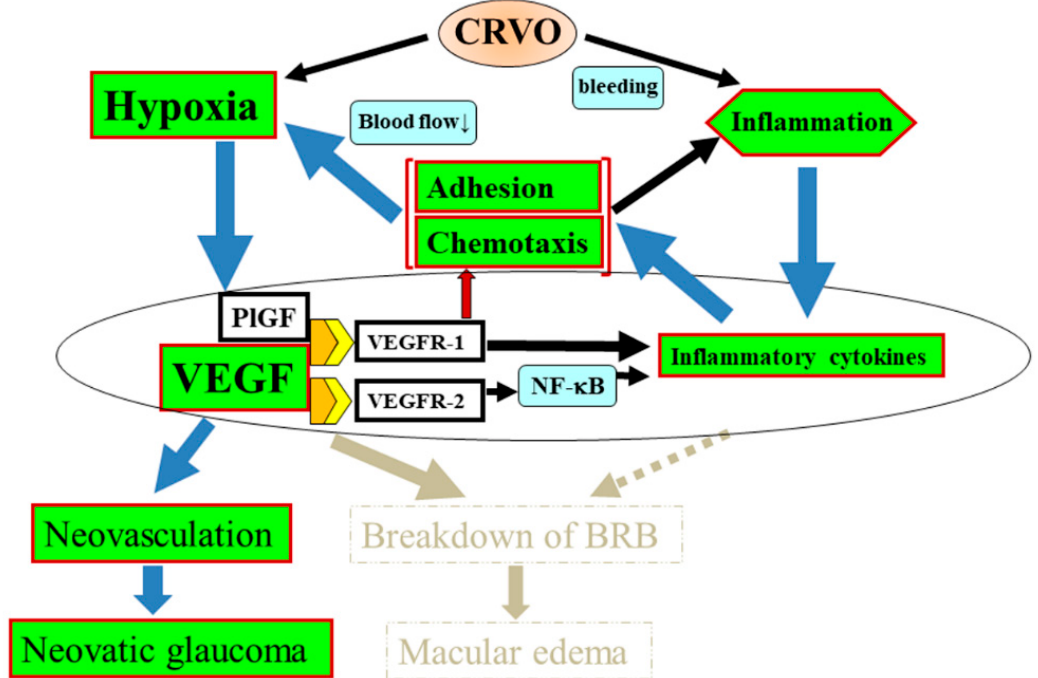
Figure 4. Mechanism of neovascularization pathogenesis in central retinal vein occlusion (CRVO). CRVO is associated with elevated expression of inflammatory cytokines such as MCP-1 and ICAM-1, which leads to leukocyte abnormalities and a decrease in retinal blood flow velocity. The slowing of the blood flow creates a positive feedback loop that further exacerbates ischemia. In addition, the resultant leukocyte chemotaxis and adhesion enhance inflammation, creating a second positive feedback loop. As a result, the risk of CRVO developing from nonischemic to ischemic increases. Finally, hypoxia causes excessive overexpression of VEGF, which results in vitreous hemorrhage and neovascular glaucoma.